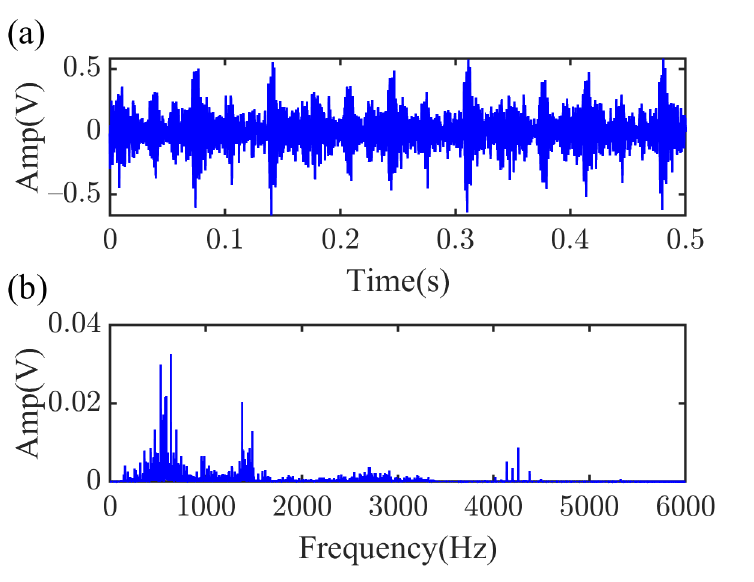
Figure 5. Vibration signal of outer race defective bearing: ( a ) time waveform; ( b ) Fourier